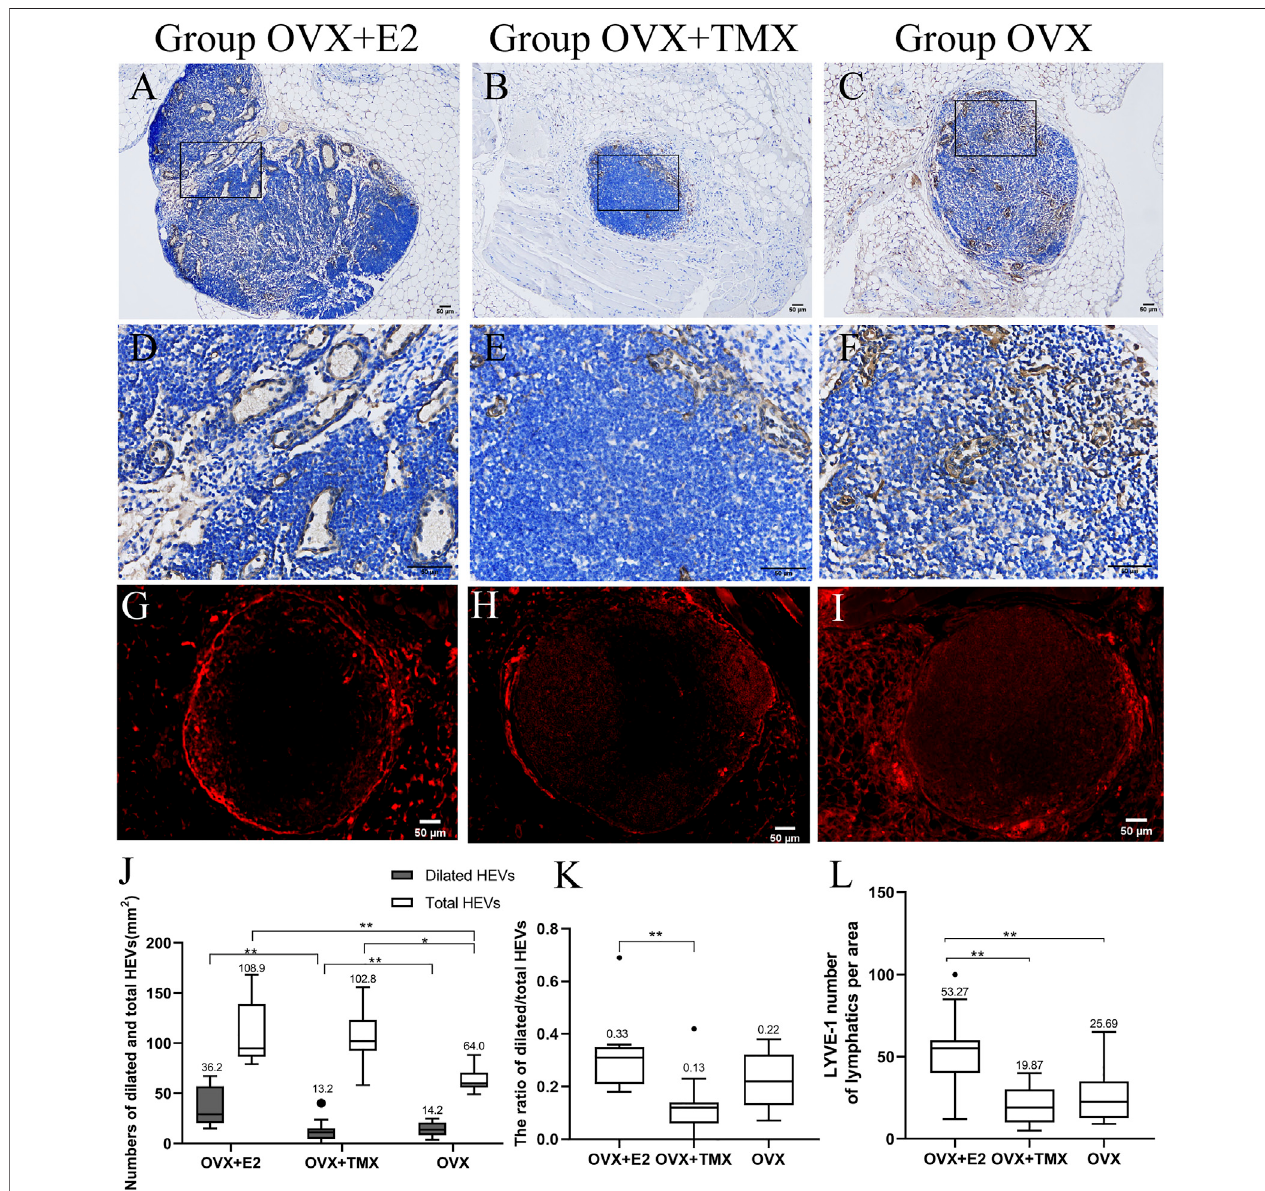
FIGURE3| Highendothelialvenules(MECA-79+)andlymphatics(LYVE-1+)oftransferredlymphnodes. (A,D) Highendothelialvenulesoftransferredlymphnodes in the OVX + E2 group. (B,E) High endothelial venules of transferred lymph nodes in the OVX + TMX group. (C,F) High endothelial venules of transferred lymph nodes in theOVXgroup. (G) LymphaticsoftransferredlymphnodesintheOVX+E2group. (H) LymphaticsoftransferredlymphnodesintheOVX+TMXgroup. (I) Lymphaticsof transferredlymphnodesintheOVXgroup. (J) Numberoftotalanddilatedhighendothelialvenulesinthreegroups. (K) Ratioofdilated/totalhighendothelialvenules in three groups. (L) Quanti fi cation of the lymphangiogenic response (LYVE-1+) in different groups. * p < 0.05, ** p < 0.01, *** p < 0.001.